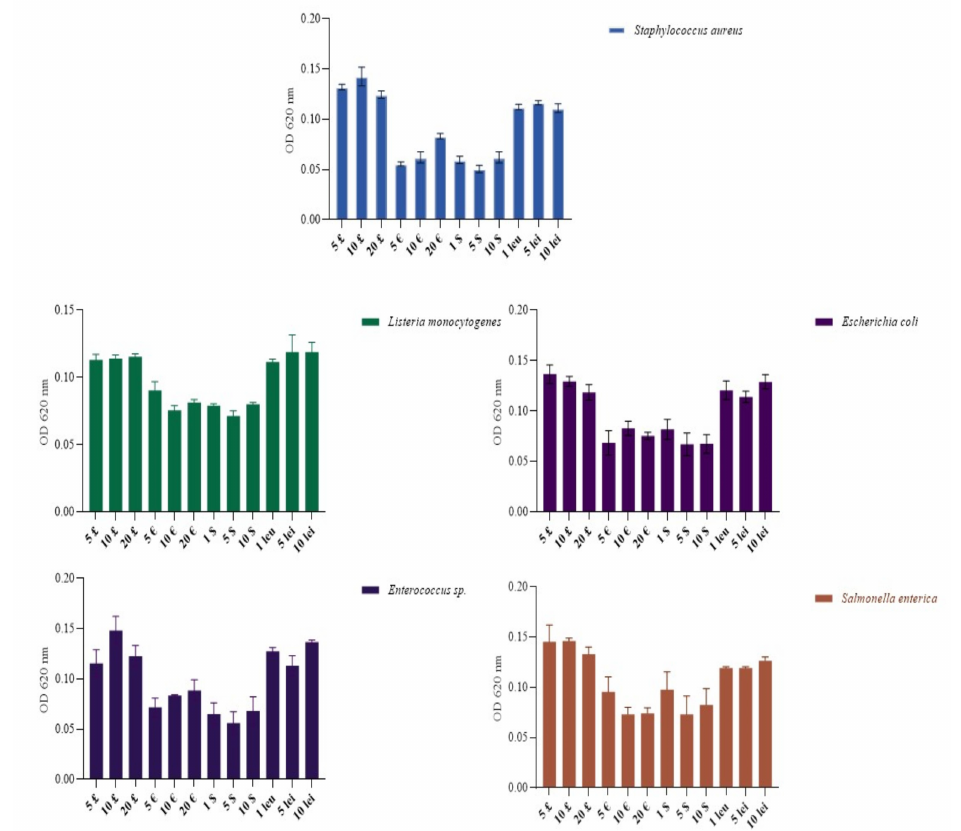
Figure 7. Adherence pattern of Staphylococcus aureus , E. coli , Enterococcus sp., Salmonella enterica and Listeria monocytogenes strains on different types of